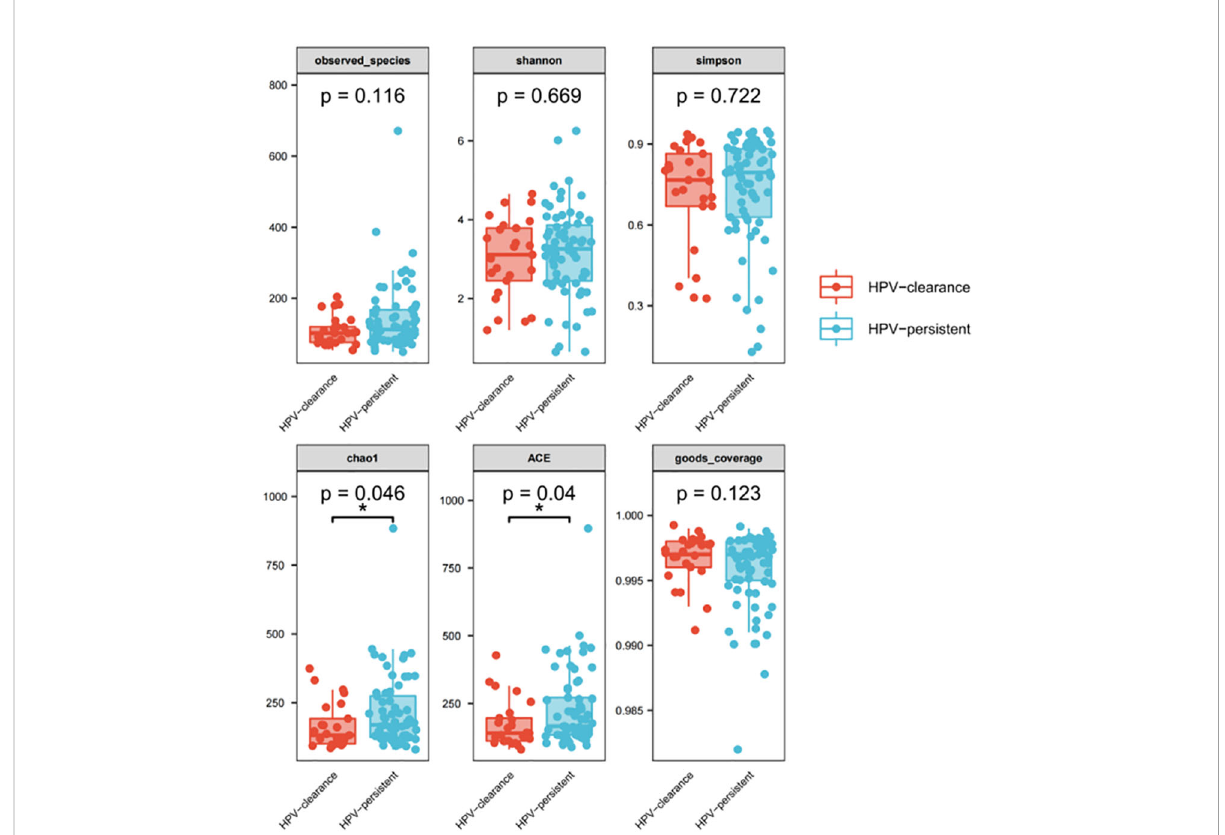
FIGURE 10 Alpha diversity index (observed - species, Shannon, Simpson, Chao1, ACE, good-coverage) in the HPV-cleared and HPV-persistent groups. The p -value on the top indicates the overall difference among three groups calculated using the Kruskal-Wallis nonparametric test method, and the asterisks on the top indicate a statistically signi fi cant difference between the two groups calculated using Dunn ’ s test (* p < 0.05, ** p <